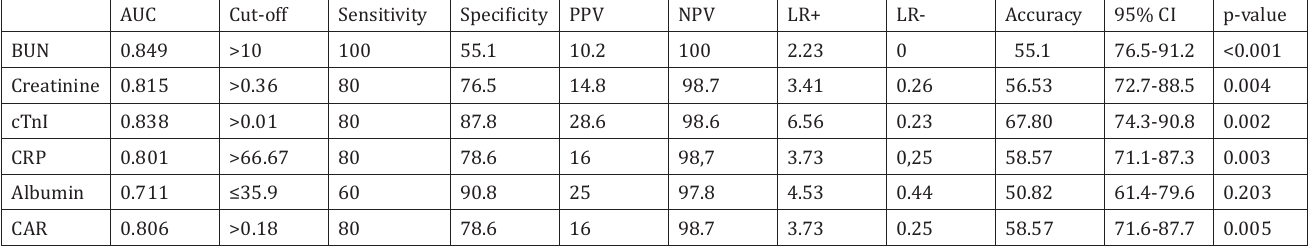
Ability of the investigated laboratory parameters to predict 30-day all-cause mortality following ED admission